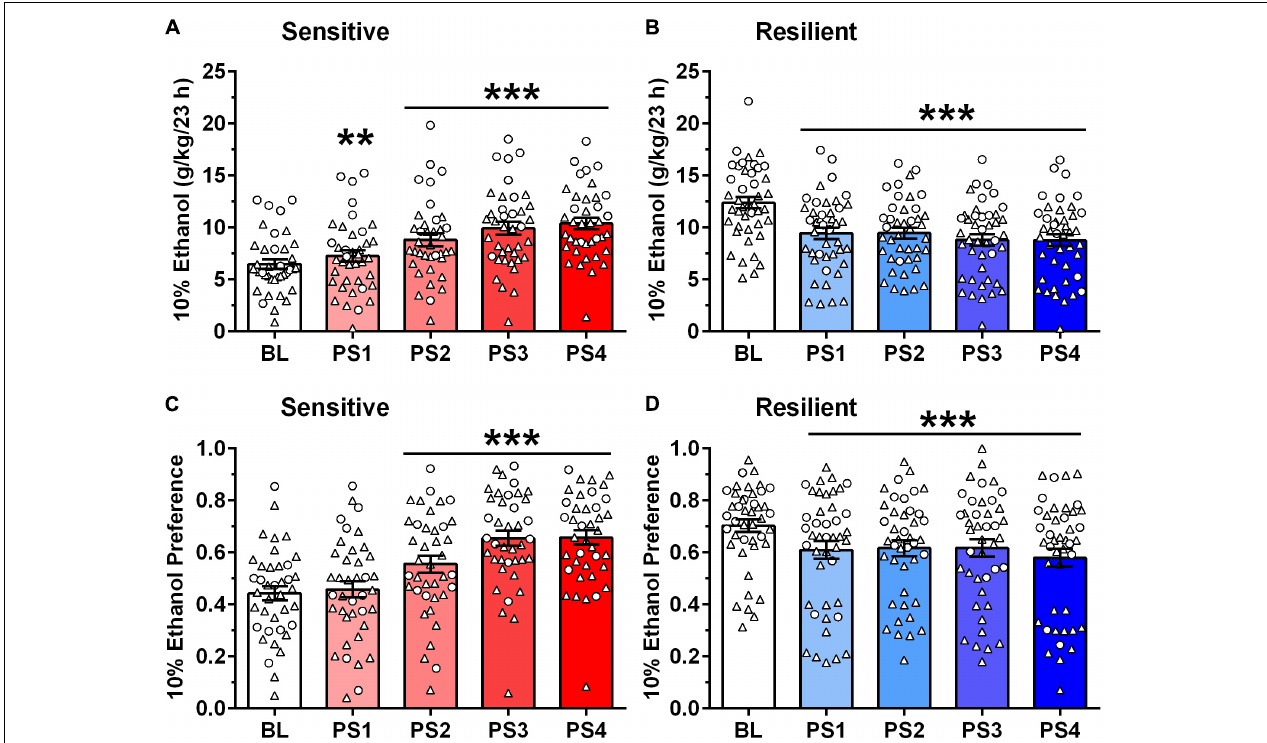
FIGURE 3 | Different pattern of ethanol intake (A,B) and preference (C,D) after intermittent predator stress (PS) in “sensitive” vs. “resilient” subgroups. Depicted are mean ± SEM intake of 10% ethanol (g/kg/23 h) intake (A,B) and 10% ethanol preference (C,D) for the “sensitive” and “resilient” animals depicted in Figure 2 . Individual data points are shown for the sexes combined (males = triangles; females = circles). Ethanol intake and preference were averaged into five blocks: baseline (BL), PS1 (after first PS, 2 days), PS2 (after second PS, 3 days), PS3 (after third PS, 2 days), and PS4 (after fourth PS, 3 days). (A,B) Ethanol intake began increasing significantly vs. BL after PS1 in the “sensitive” subgroup, whereas ethanol intake decreased significantly vs. BL after PS1-4 in the “resilient” subgroup. Following PS4, ethanol intake increased over BL by 62% (males) and 59% (females) in the “sensitive” subgroup, and decreased from BL by 30% (males) and 27% (females) in the “resilient” subgroup. (C,D) Ethanol preference increased significantly vs. BL after PS2-4 in the “sensitive” subgroup, whereas ethanol preference decreased significantly vs. BL after PS1-4 in the “resilient” subgroup. Following PS4, ethanol preference increased over BL by 44% (males) and 61% (females) in the “sensitive” subgroup, and decreased from BL by 18% (males) and 16% (females) in the “resilient” subgroup. ** p < 0.01, *** p ≤ 0.001 vs. respective